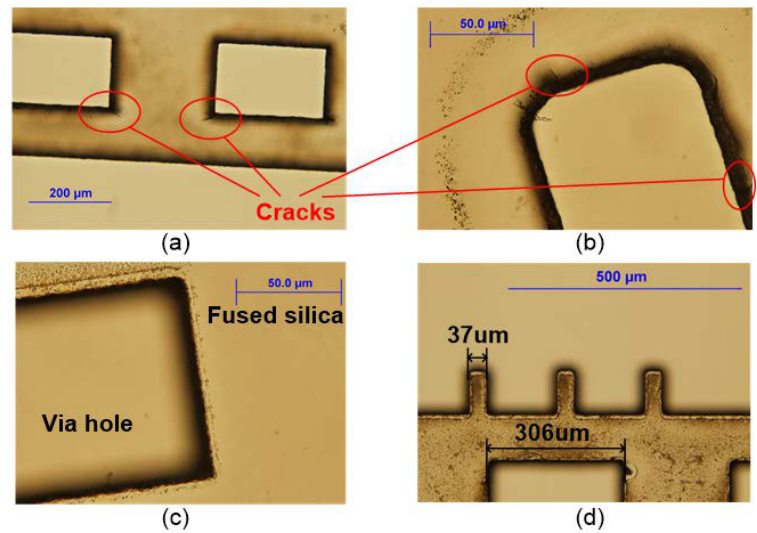
Figure 4 . Appearances of etched samples under microscope: ( a ) 115 mW and 50 passes; ( b ) 115 mW and 50 passes with round corners; ( c ) 102 mW and 60 passes; ( d ) Accuracy of laser etching.